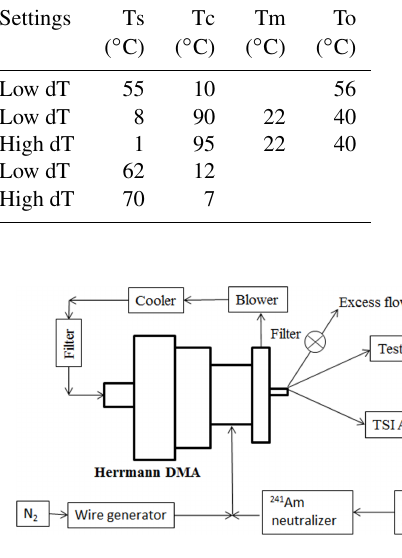
Figure 4. Experimental setup to measure d50 for charged